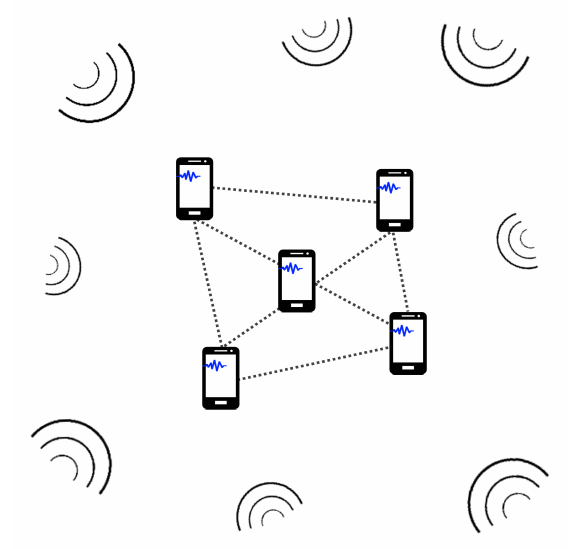
Figure 1. A group of devices that are able to communicate with each other can exploit ambient sounds to localize themselves and the origins of the